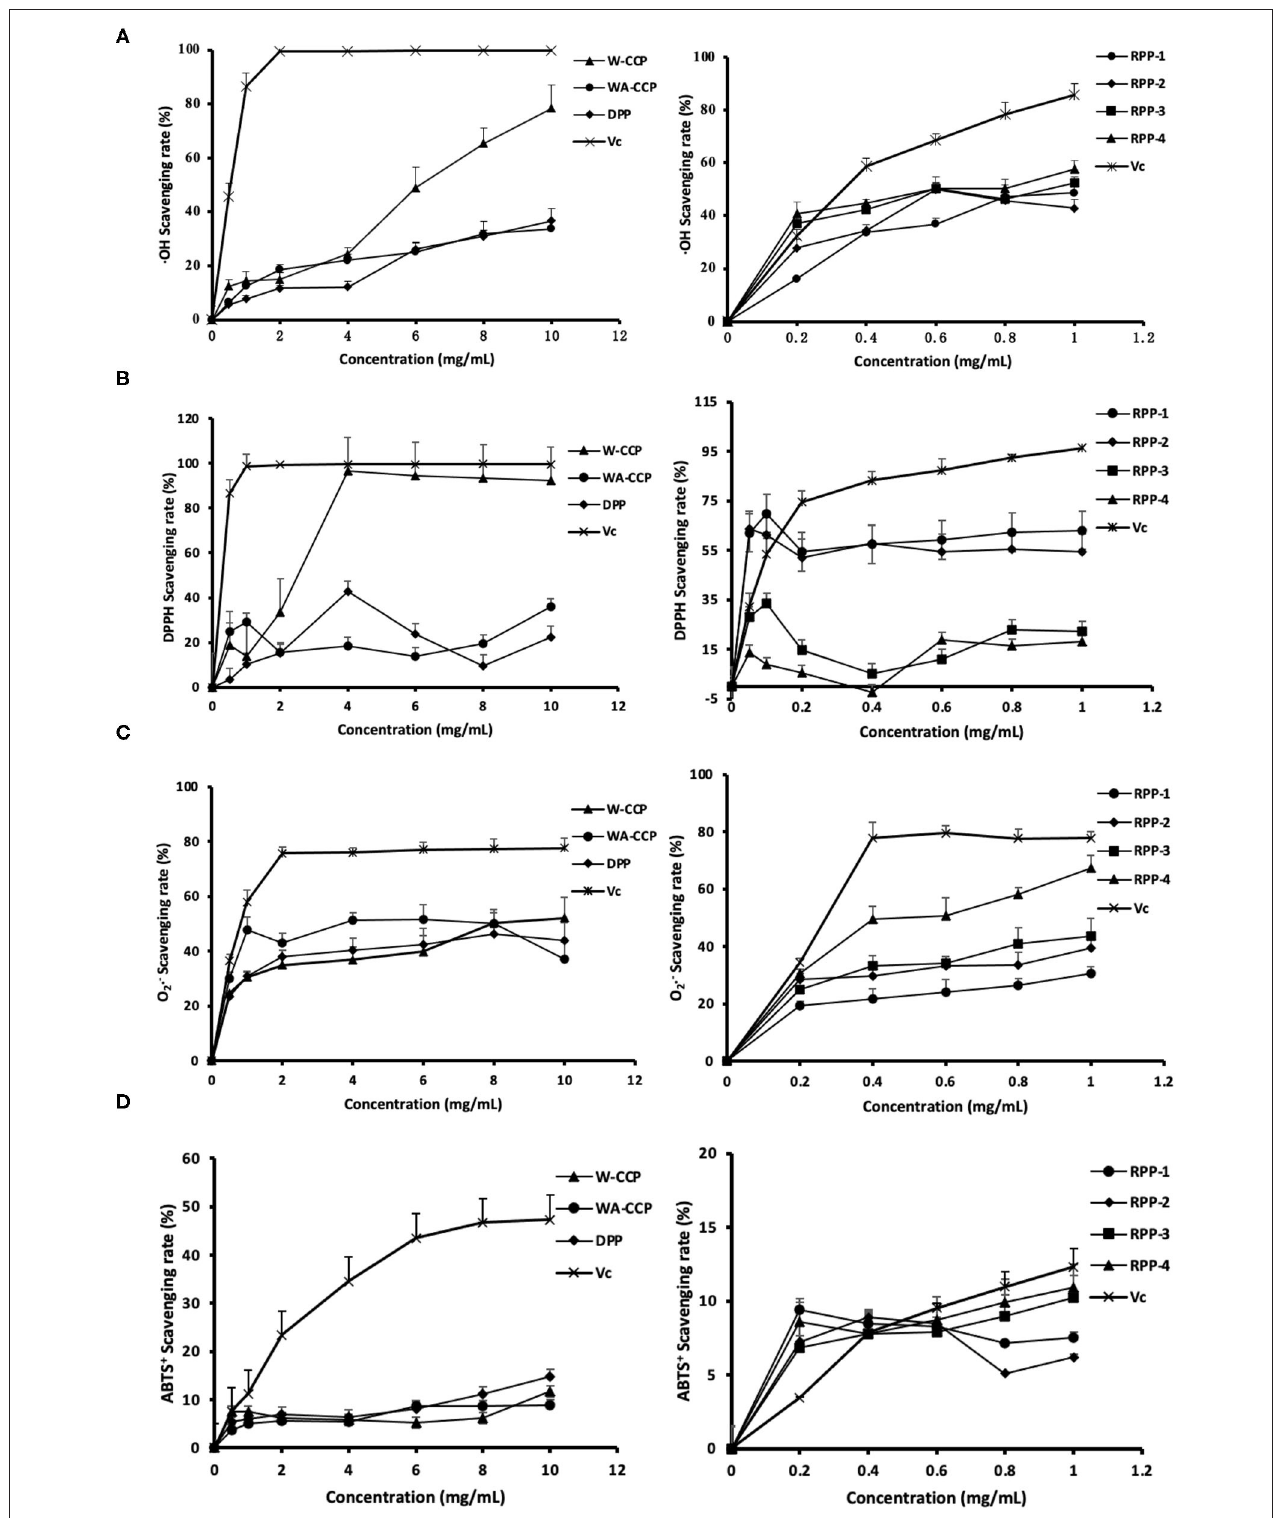
FIGURE 4 | Antioxidant activities of four pumpkin polysaccharides: W-CCPs, WA-CCPs, DPPs, and RPPs. (A) Hydroxyl (OH) radical scavenging abilities. (B) 1,1-diphenyl-2-picryl-hydrazyl (DPPH) radical scavenging abilities. (C) Superoxide anion (O − 2 ) radical scavenging abilities. (D) 2,20-Azino-bis-3-ethylbenzthiazoline- 6-sulphonic acid (ABTS + ) radical scavenging abilities. V C is the positive control. Each value was represented as mean ± SD of three independent experiments. W-CPPs, water-extracted crude pumpkin polysaccharides; WA-CPPs, crude pumpkin polysaccharides extracted by water and alcohol; DPPs, deproteinized pumpkin polysaccharides; RPPs, refined pumpkin